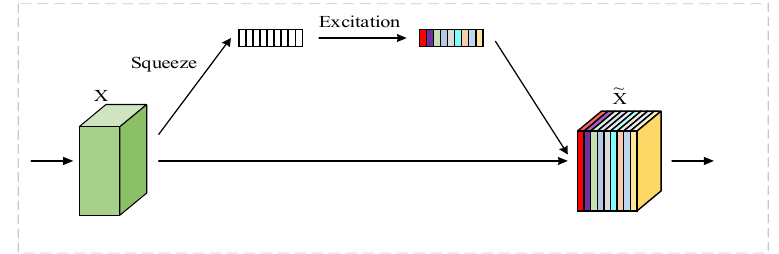
Figure 8. Illustration of the SE attention.